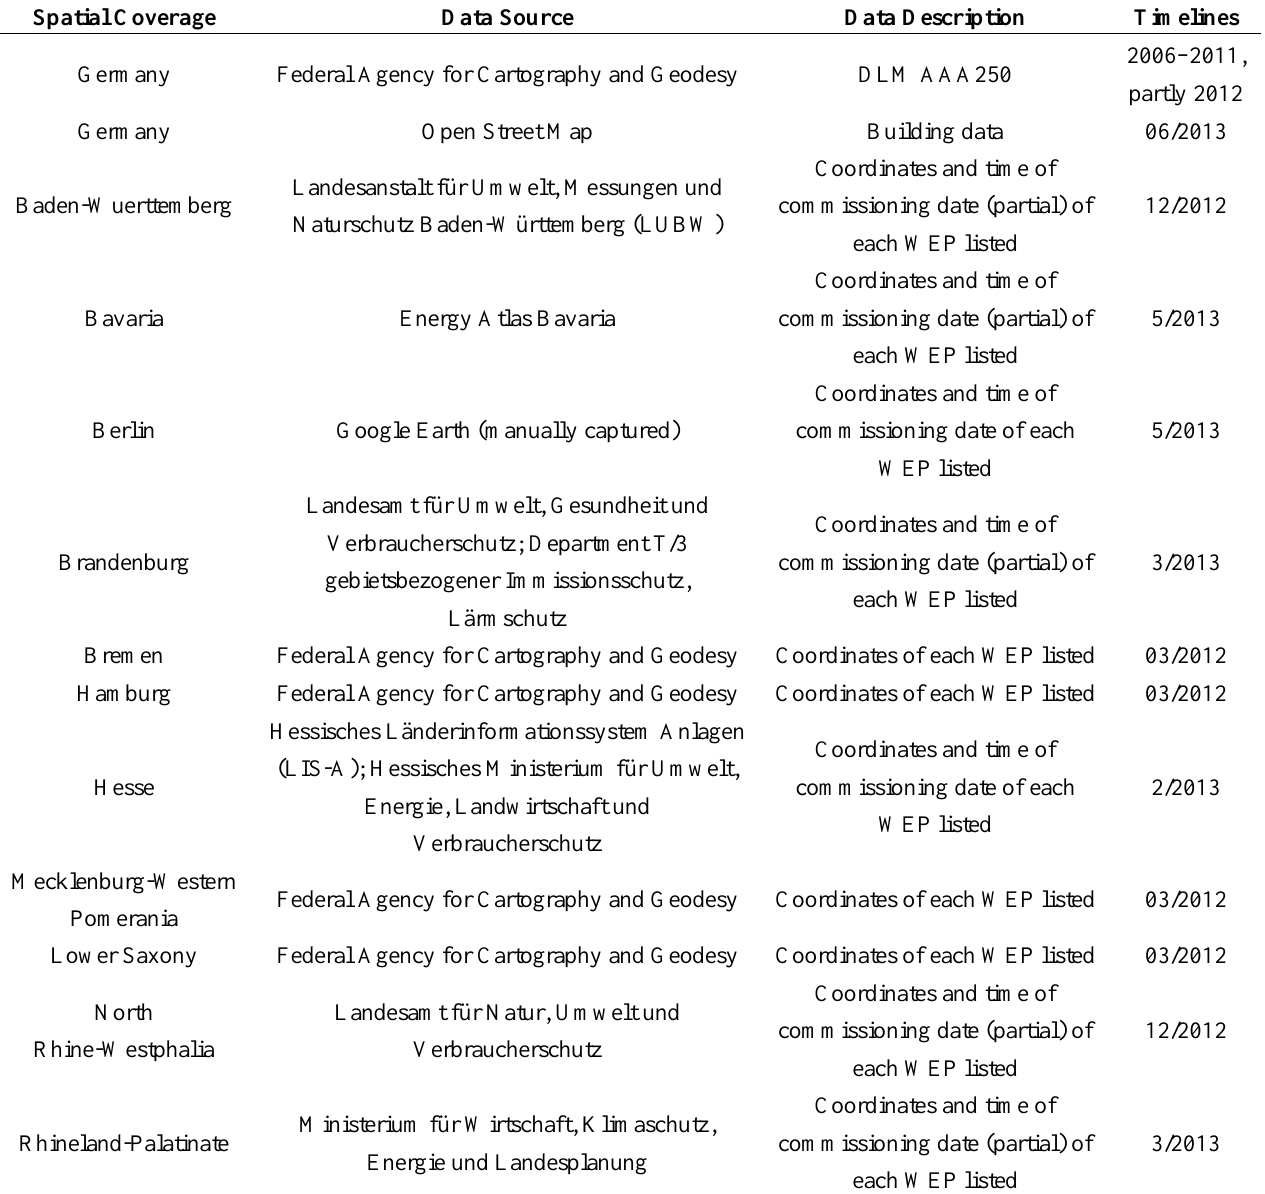
Table 1. Information on data sources, data description and